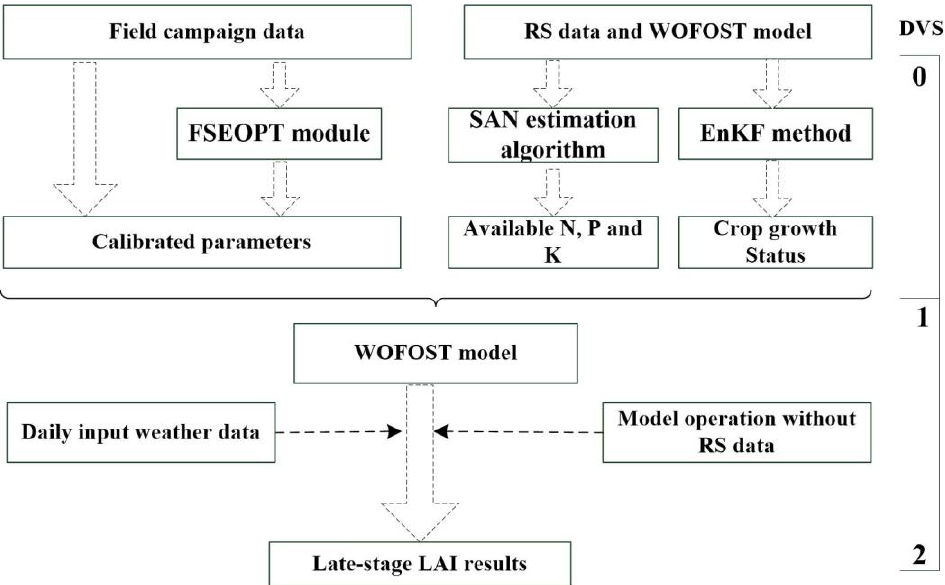
Figure 4. Processes of LAI estimation for the late stage using hybrid method (DVS: the development stage of the crop, DVS = 1 indicates the beginning of tasseling period for maize in this study). Figure 4 indicates that the hybrid method can be considered as a specific crop model method in which the WOFOST model without using RS data was run from the end of the mid stage (DVS = 1). To enable the simulation of WOFOST, the parameters of crop growth status with DVS = 1 and RS-based SAN contents were required as initial inputs. Then, the WOFOST model was self-operated and daily LAI values were output as the late-stage results. This method was named as the hybrid method to distinguish it from the WOFOST model used in the assimilation method.